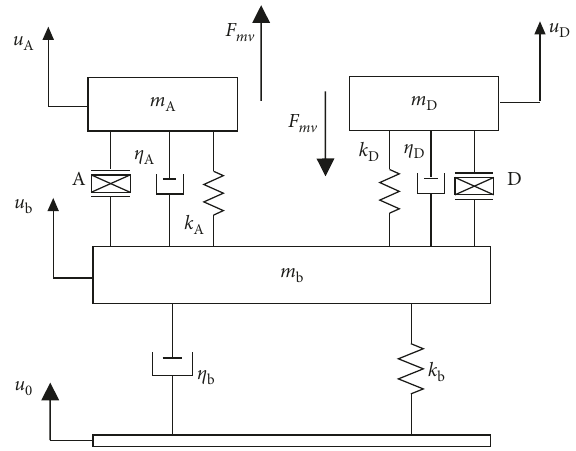
Figure 4: Equivalent model of the proposed electro-magneto- mechanical